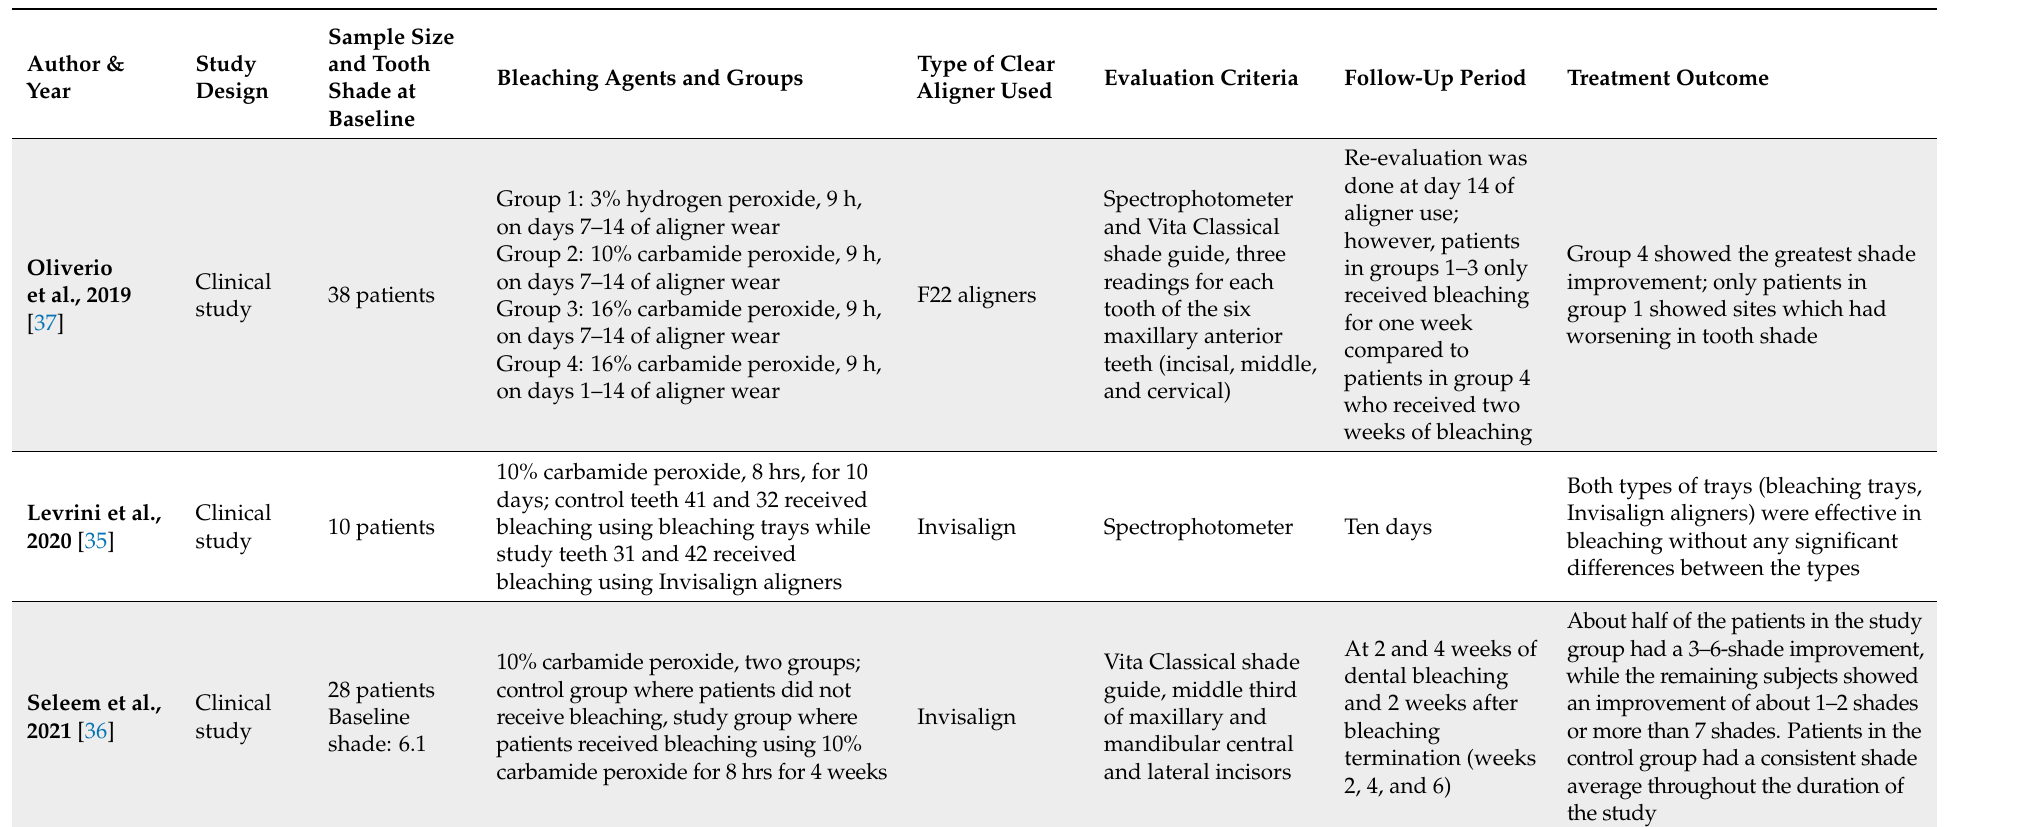
Table 1. Overview of the included